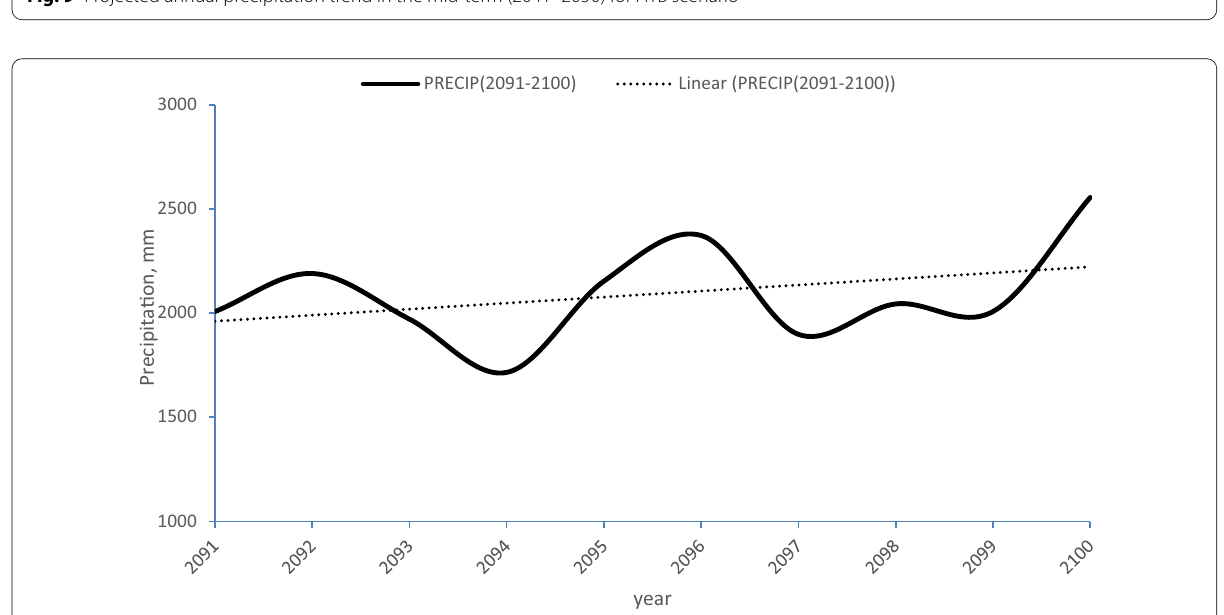
Fig. 9 Projected annual precipitation trend in the mid-term (2041–2050) for A1B scenario